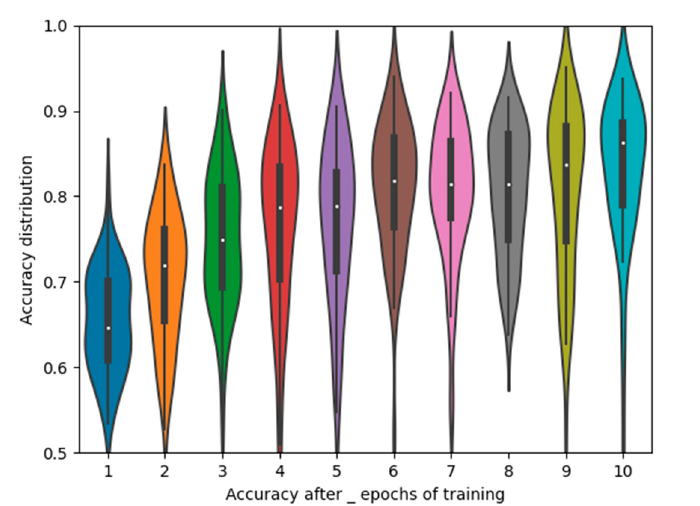
13 of 32 Figure 7. Averaged confusion matrix for ResNet18 on SAR data. Table 2. SAR-only ResNet18 intraclass variance (Var) and standard deviation (SD). Class